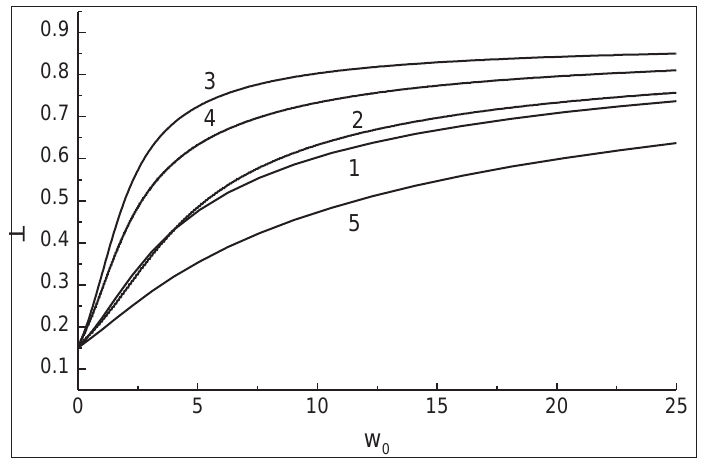
Figure2.TheoreticaltransmissioncurvesT=Wout=Winofthesaturableabsorber